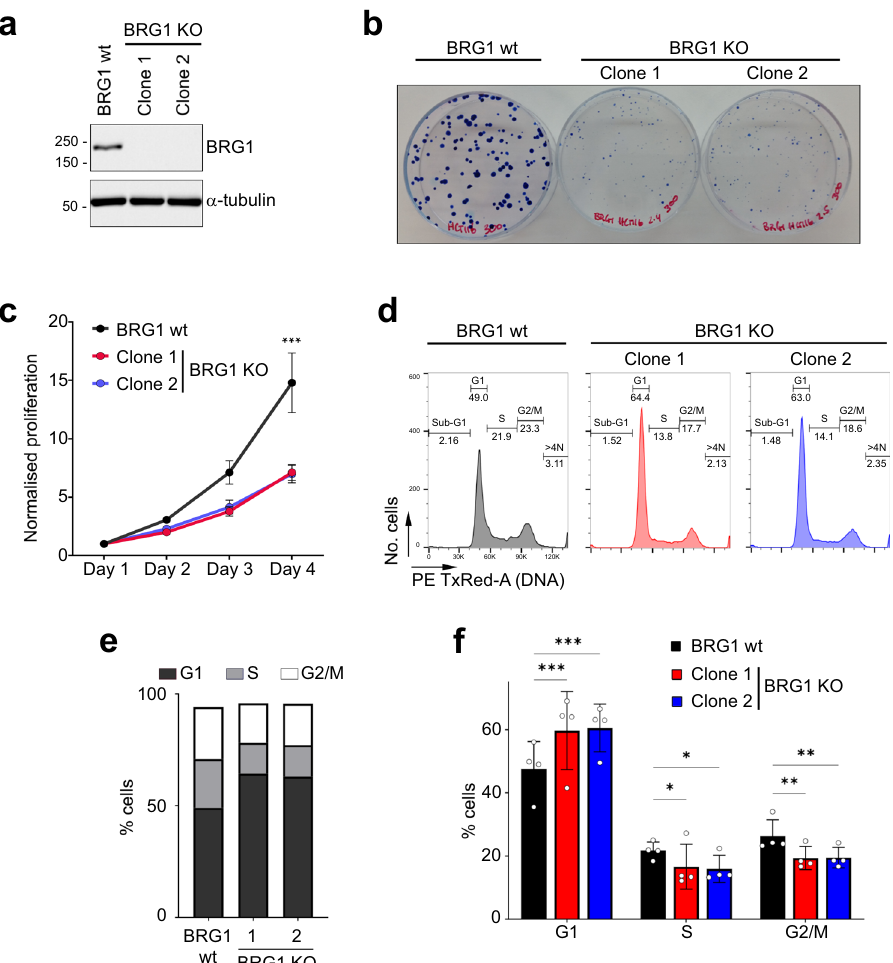
Fig. 1 BRG1 loss leads to a loss of fi tness and altered cell cycle pro fi le. a Western blot analysis of BRG1 in whole-cell extracts prepared from HCT116 cells and two HCT116-derived BRG1 knockout clonal cell lines. α -tubulin was used as a loading control. Similar results were obtained in three independent repeats. b Clonogenic assay showing the difference in colony size between HCT116 cells and two BRG1 knockout clones grown for 10 days. c Normalised proliferation from three independent experiments monitored by CellTiter-Glo Luminescent Cell Viability assay between HCT116 cells and two BRG1 knockout clones. Data were presented as the mean ± SEM; n = 3. The p value was calculated with two-way ANOVA-Dunnet. *** p < 0.001. d BRG1-de fi cient cells have an altered cell cycle pro fi le. DNA content was analysed by fl ow cytometry and representative pro fi les of the HCT116 or BRG1 knockout clones are shown. e Quanti fi cation of cells (%) in each cell cycle phase of cells analysed by fl ow cytometry in d . f Quanti fi cation of cells (%) in G1, S and G2/M cell cycle phases from fl ow cytometry pro fi les in HCT116 and BRG1 knockout cells. Data were presented as the mean ± SD; n = 4. The p value was calculated with two-way ANOVA-Dunnett. * p < 0.05, ** p < 0.01 and *** p <